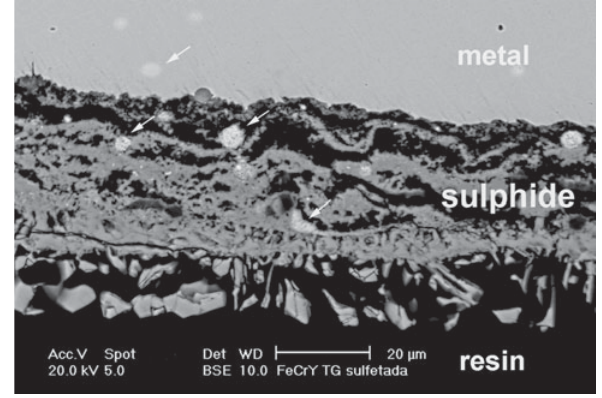
Figure 5. Cross-section of FeCrY alloy sulphidised at 700 °C for 2 h.